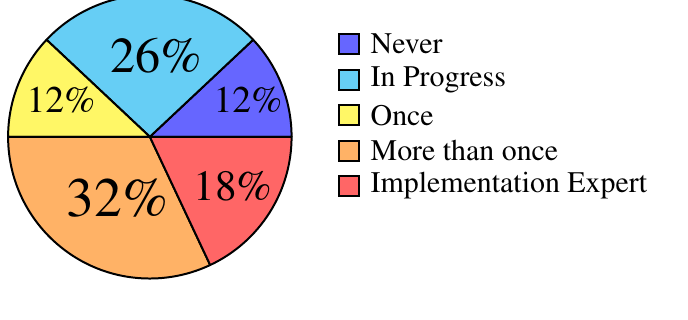
Figure A6. How often have you implemented IPv6? (n =